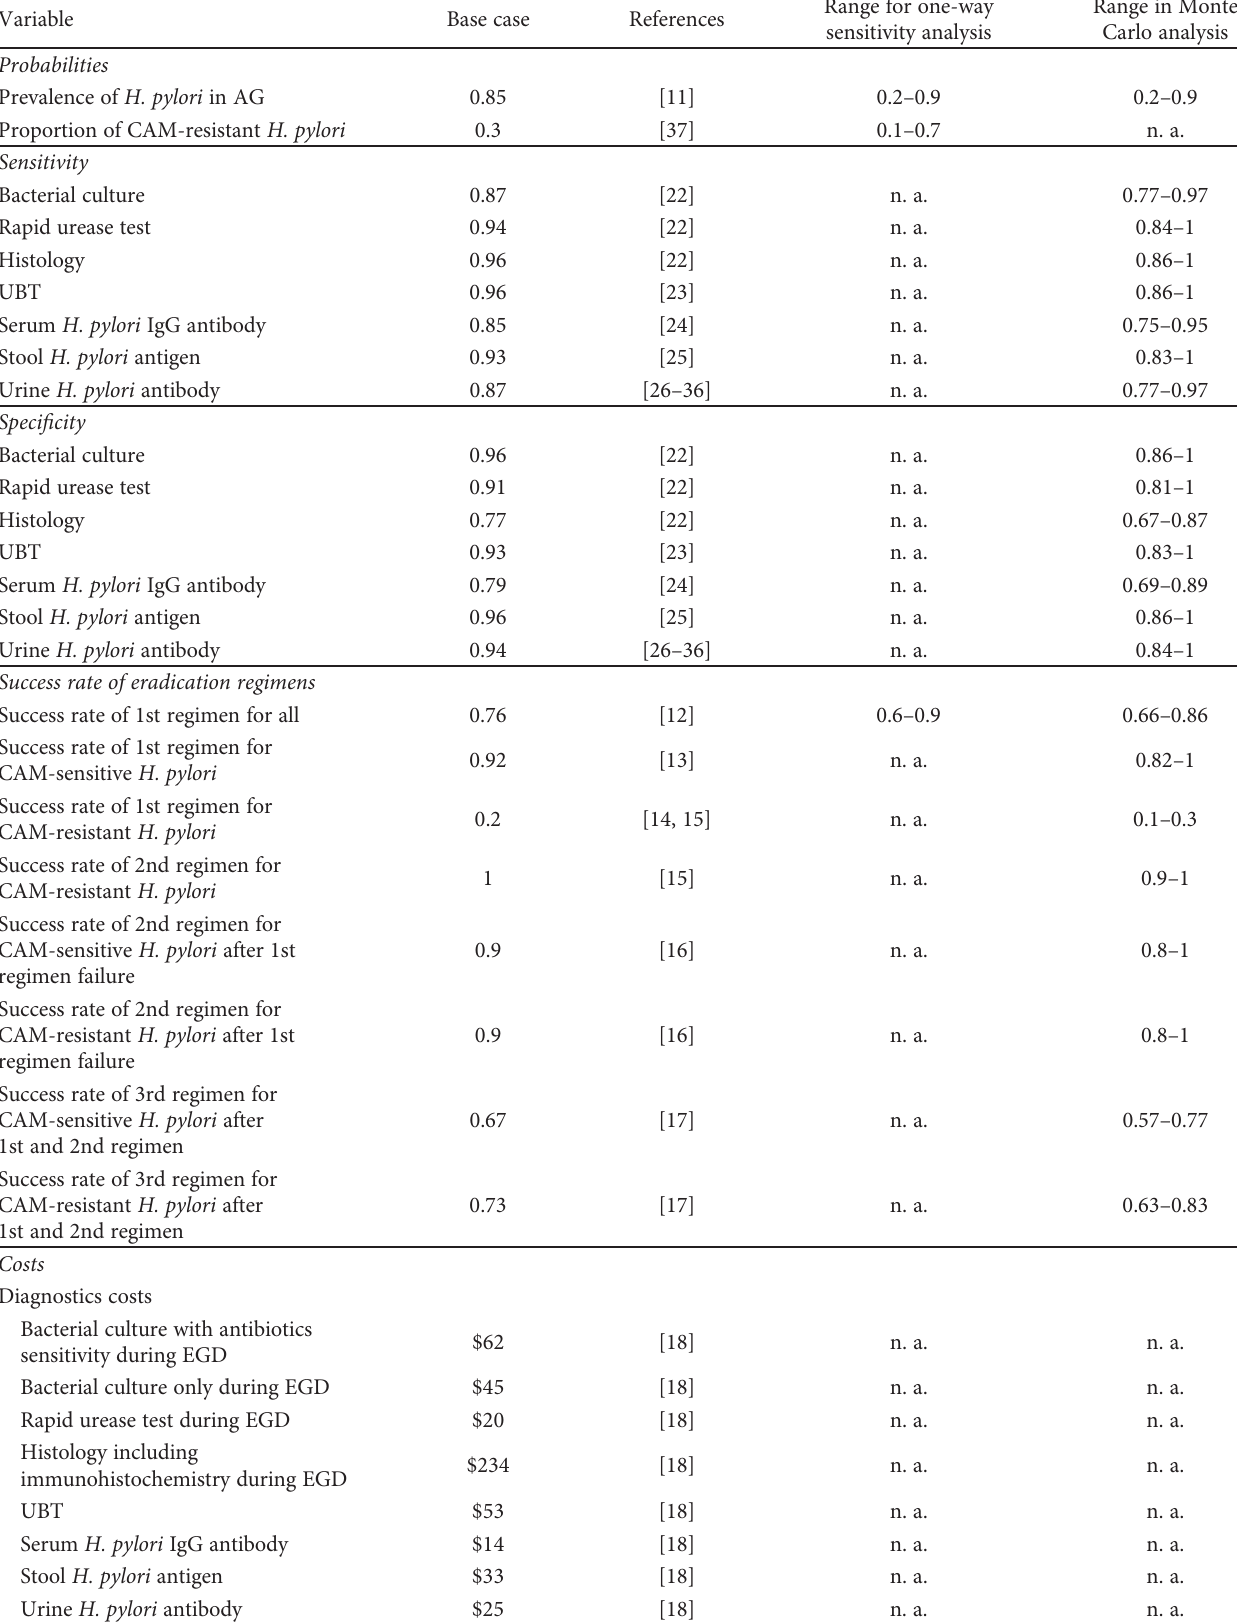
Table 1: Probabilities and